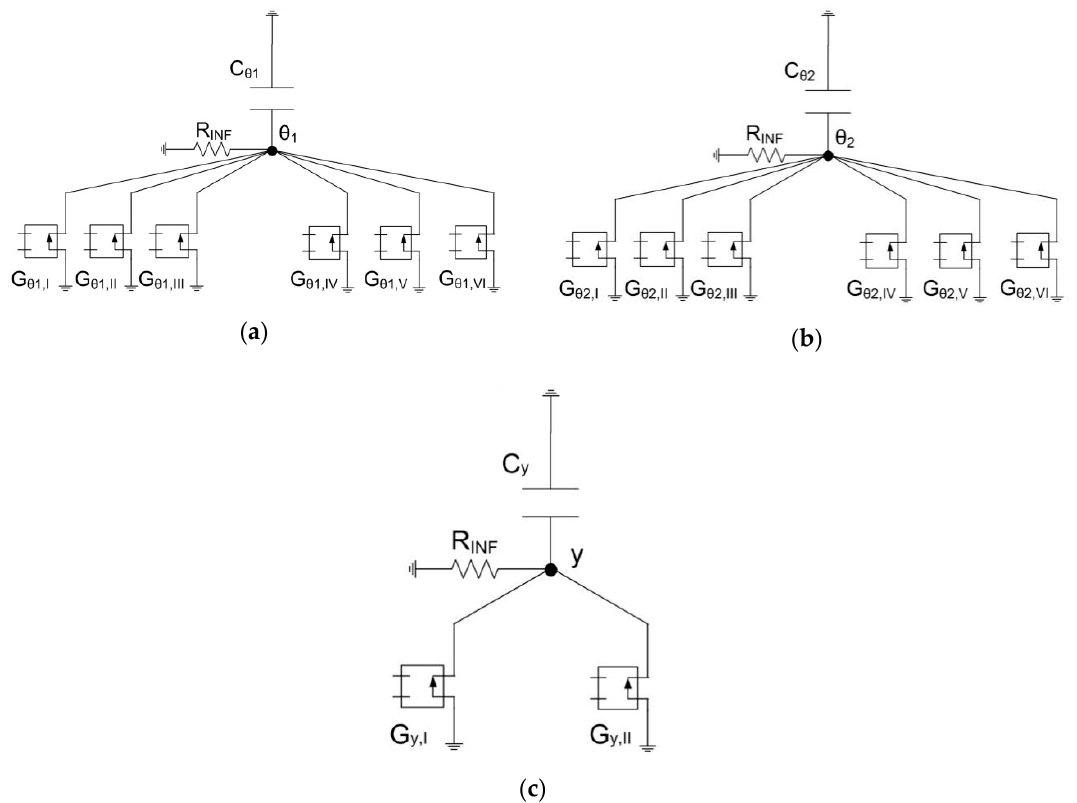
Figure 3. Network model: ( a ) variable 1, ( b ) variable 2 and ( c ) variable y .